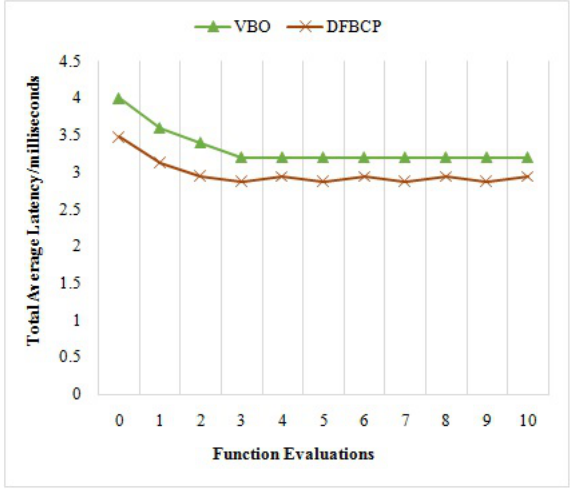
Figure 10. Convergence plots for capacitated controller placement problem for EU-GÉANT